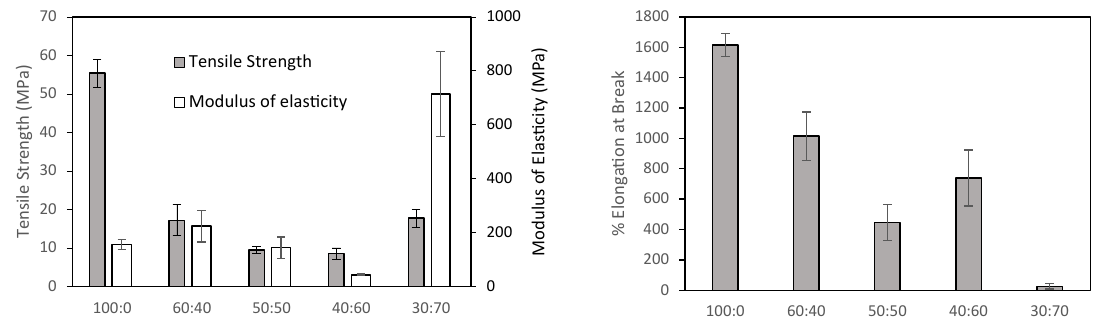
Figure 2. E ff ect of blend ratio of PCL:Starch on ( a ) tensile strength and modulus of elasticity and ( b ) percentage of elongation at